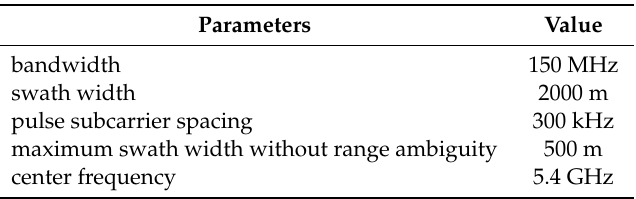
Figure 12. Simulation results. ( a ) origin scene. ( b ) reconstructed image with the range ambiguity of OFDM chirp signal. ( c ) reconstructed image with the proposed system. Table 2. Parameters Used in Figure 12b.